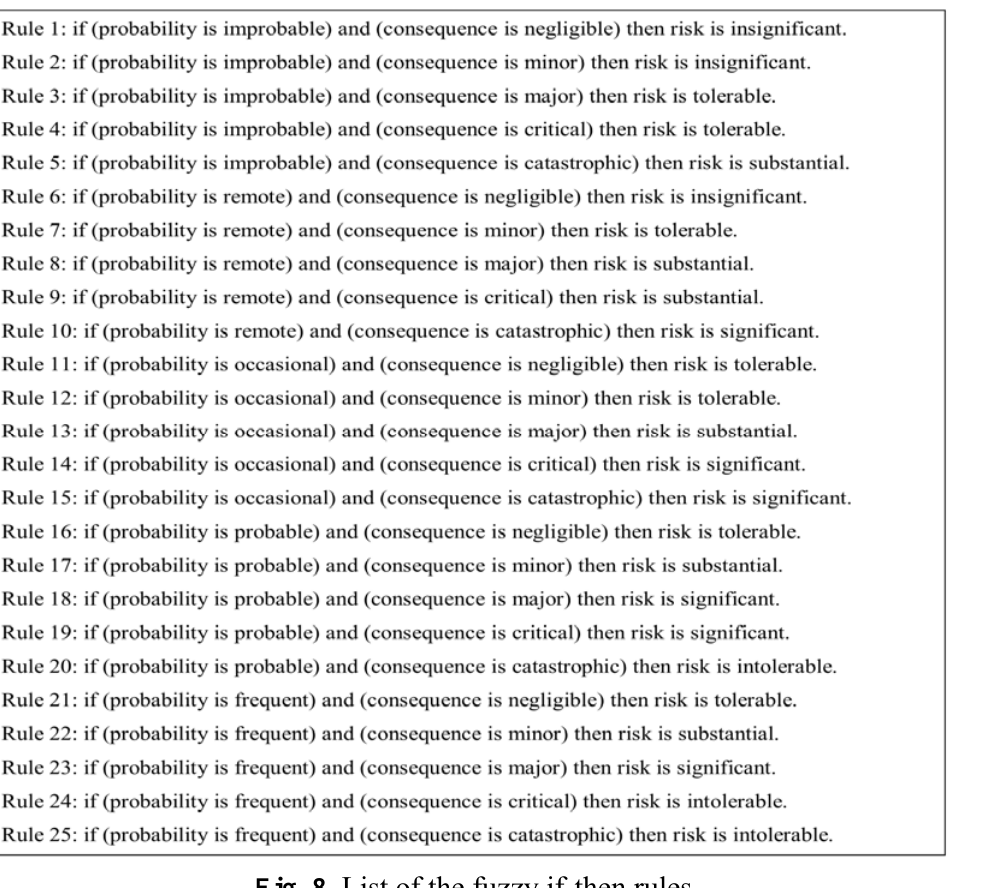
Fig. 8. List of the fuzzy if-then rules